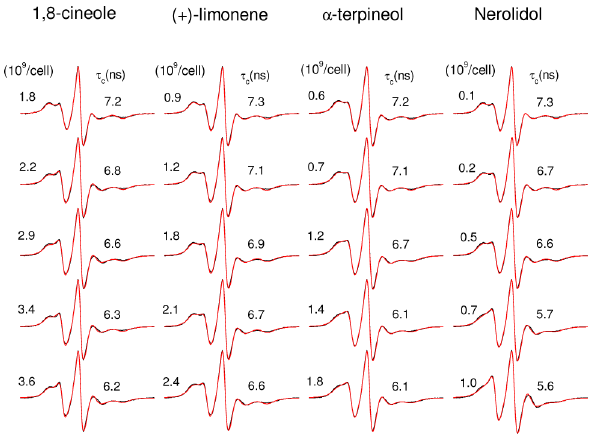
Figure 4. EPR spectra of spin-labeled Leishmania plasma membrane. Experimental (black lines) and best-fit (red lines) EPR spectra of 5-DSA in the plasma membranes of Leishmania amazonensis promastigotes for samples treated with terpenes at several concentra- tions around their IC 50 (two concentrations below and three above the IC 50 ). The EPR spectra are representative of three independent experiments and the means and S.D. of the rotational correlation time ( t c ) obtained from the NLLS fitting are indicated. The spectra of the control samples (without treatment) were similar to those already shown in Fig. 2 ( t c =8.1 6 0.2 ns).